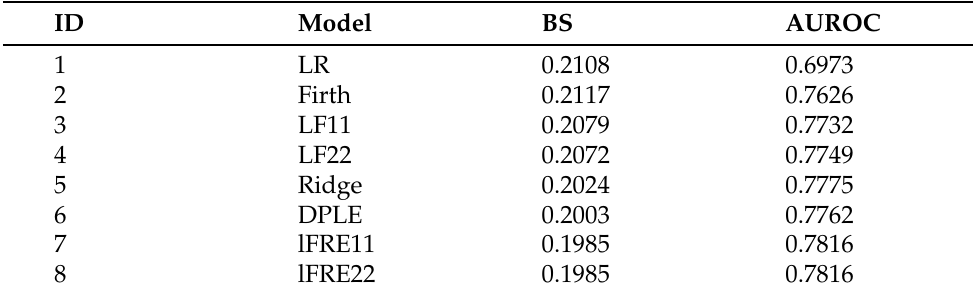
Table 5. Real data example: BS and AUROC obtained by fitting LR, Firth, LF11, LF22, Ridge, DPLE, lFRE11, and lFRE22 for a breast cancer